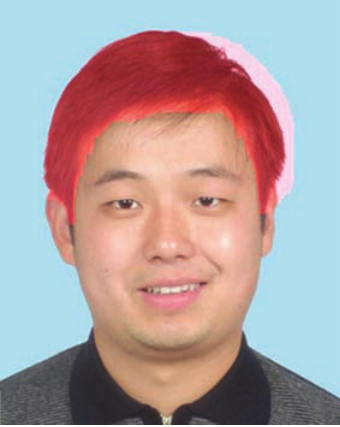
Figure 4: Initial hair region. Hair region is labeled in light